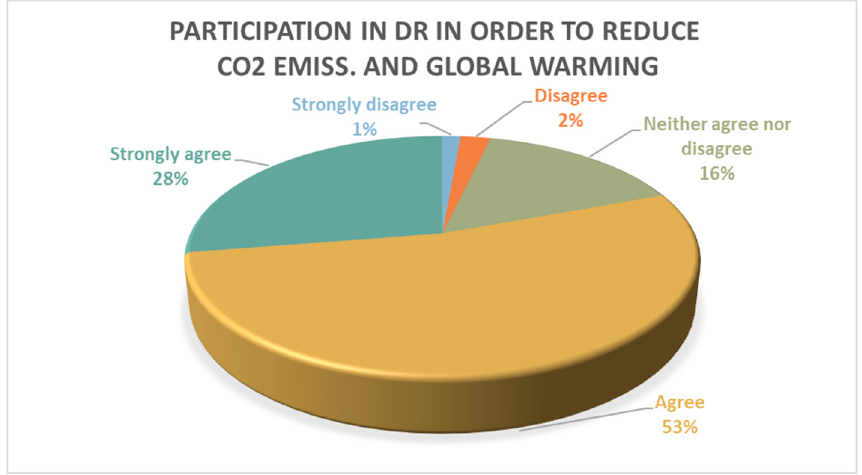
Figure 8. Participation of consumers in DR programs in order to reduce CO 2 and the global warming impact.